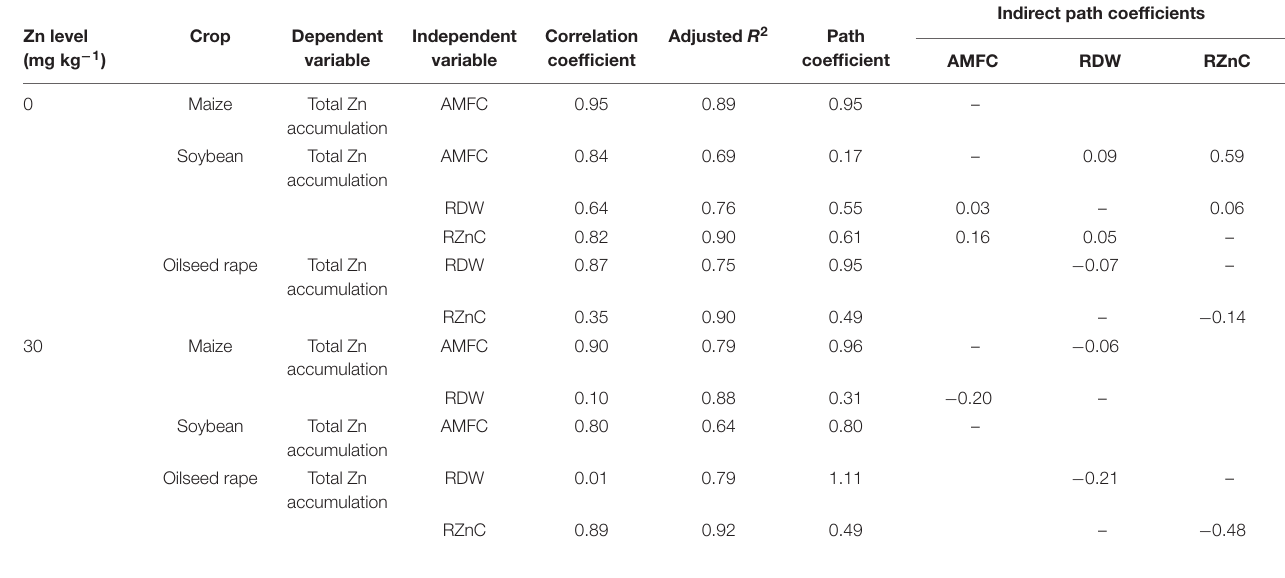
TABLE 4 | Correlations of total Zn accumulation (dependent variable) with independent variables [root Zn concentration (RZnC), root dry weight (RDW), and arbuscular mycorrhizal fungi colonization (AMFC)] for maize, soybean, and oilseed rape when Zn was applied at 0 or 30 mg kg − 1